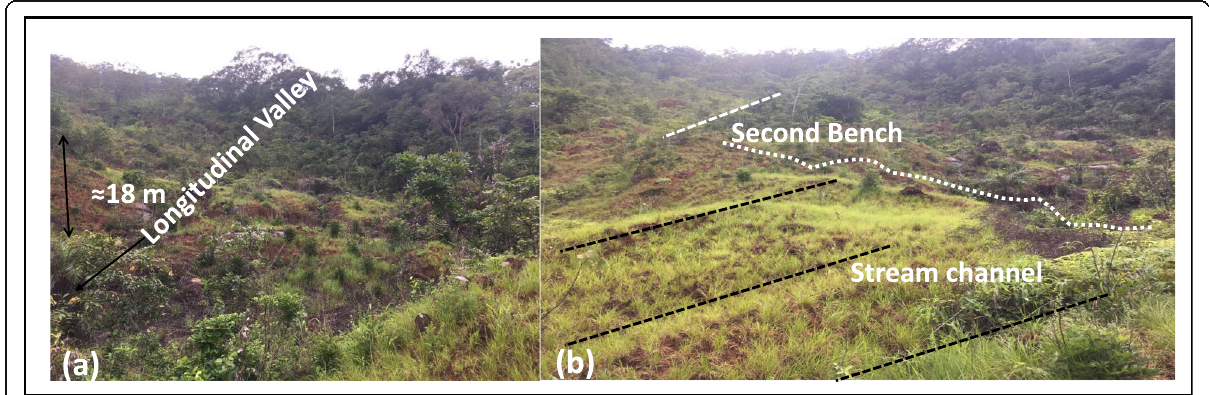
Fig. 5 Charlotte landslide conditions ( a ) Revegetated scars with regolith section at the right flank and prominent valley; ( b ) Lineament traces (white and black dashed lines) depicted by spring flows in open